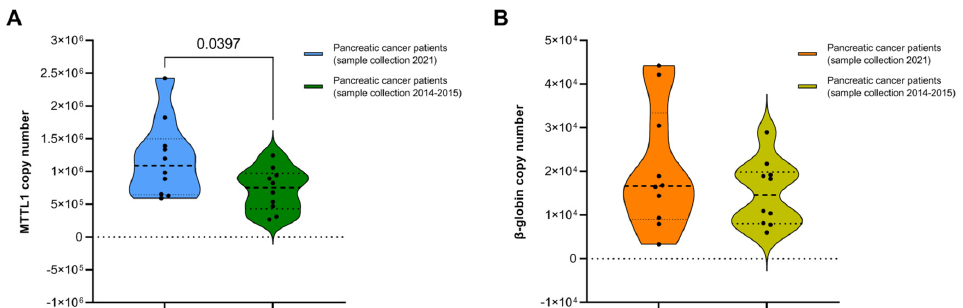
Figure 5. The effect of sample storage time on the yield of mitochondrial DNA and nuclear DNA. Comparison of mtDNA and nDNA present in whole blood samples of pancreatic cancer patients with sample collection in 2021, stored at − 20 °C prior to processing, vs. 2014–2015, stored at − 80 °C prior to processing. Comparison of ( A ) mtDNA and ( B ) nDNA in whole blood samples, followed by mtDNA isolation with the Maxwell Kit. Ten patients were recruited in each cohort. Outliers were identified and omitted using Grubb’s test (Alpha = 0.05). p -values lower than 0.05 indicate a statistically significant